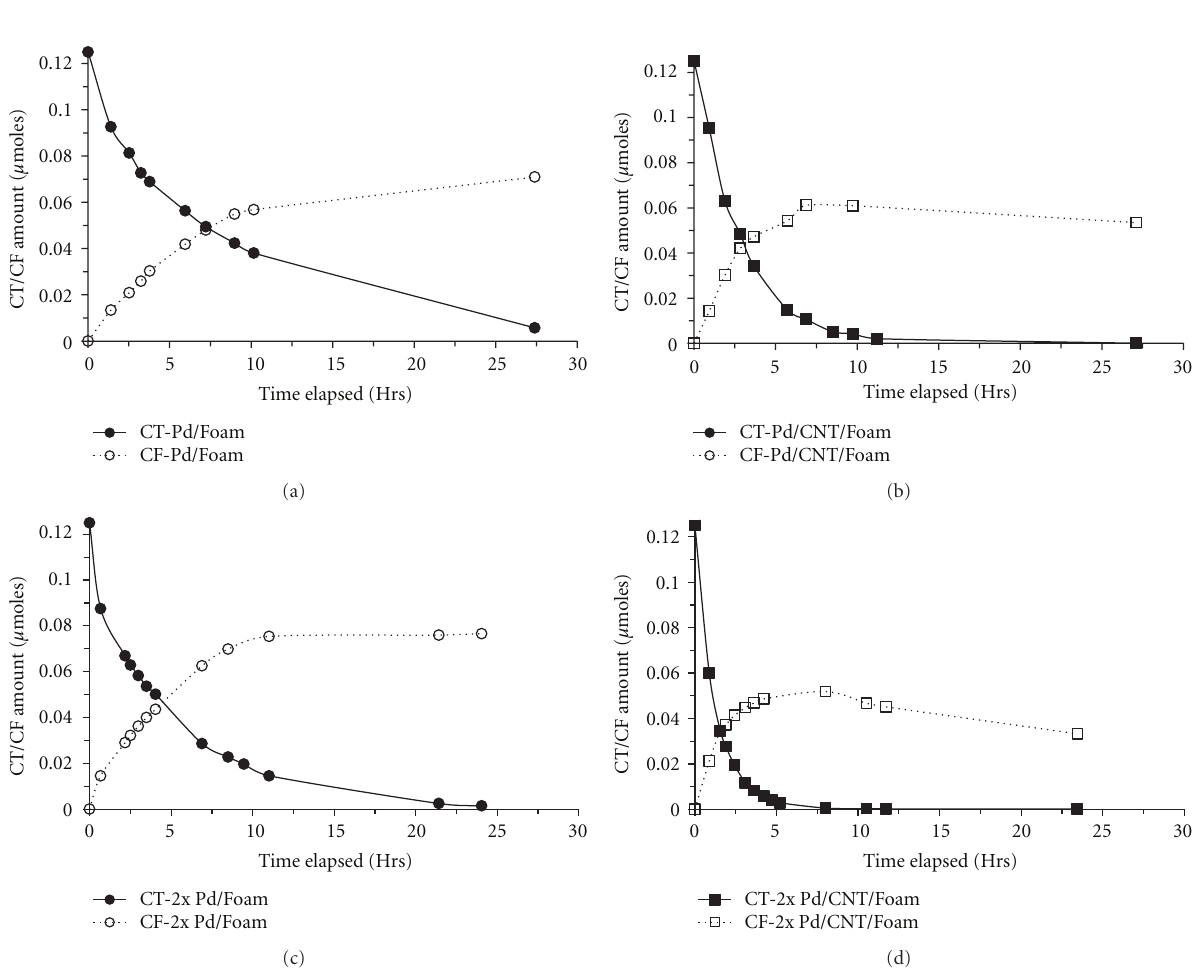
Figure 6: Carbon tetrachloride (CT) degradation and chloroform (CF) formation curves with (a) Pd/Foam, (b) Pd/CNT/Foam, (c) 2x Pd/Foam, and (d) 2x